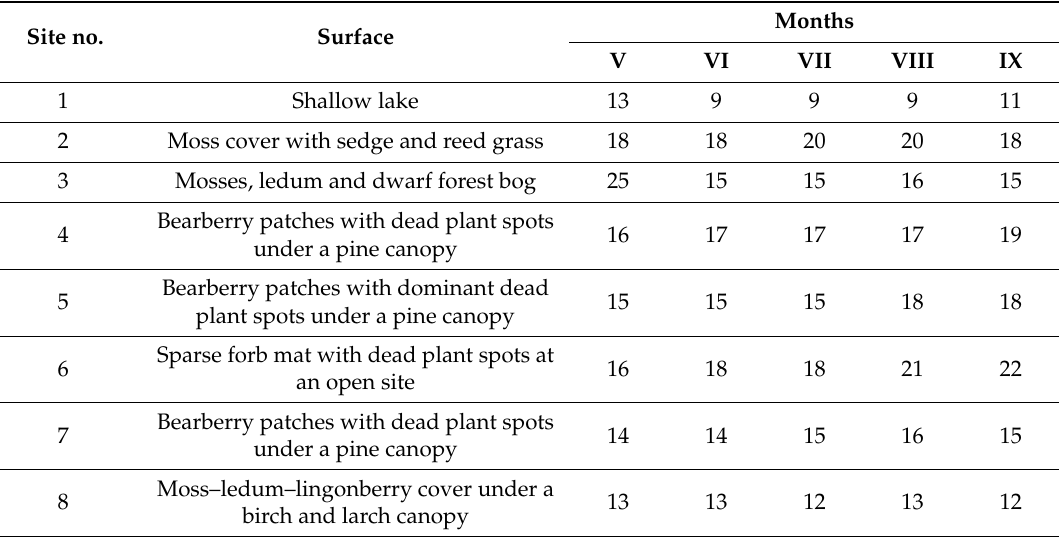
Table 1. Surface albedo at the Chabyda research sites,